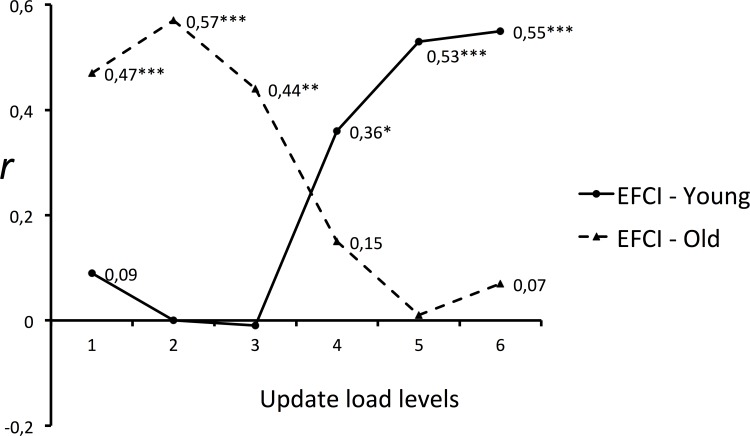
Partial Pearson correlations between Updating Working Memory task (UWMT) performance and executive functioning (EFCI) as a function of updating load level and age group.We collected performance data for the Updating Working Memory Task (UWMT) at each updating load level, and analyzed correlations with executive functioning performance, as indexed by the executive functioning composite index (EFCI). Only significant correlations with confidence intervals that did not include 0 are labeled. EFCI: Executive Functioning Composite Index. Note: * = p < .05; ** = p < .01; *** = p < .001